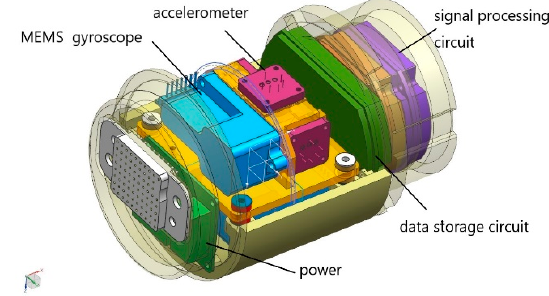
Figure 2. Inertial measurement unit components. MEMS—micro-electromechanical system.